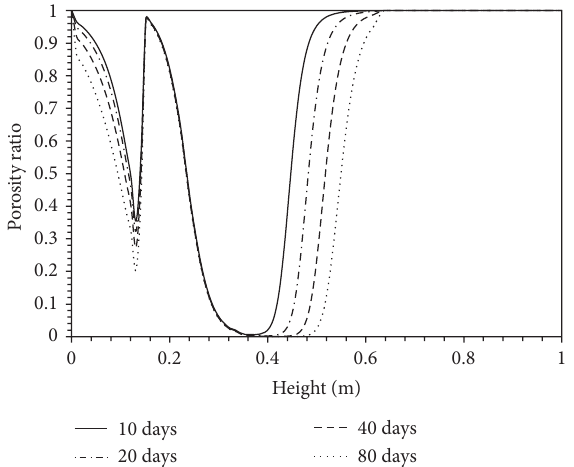
Figure 4: Permeability ratio against the height with various imbibi- tion times.